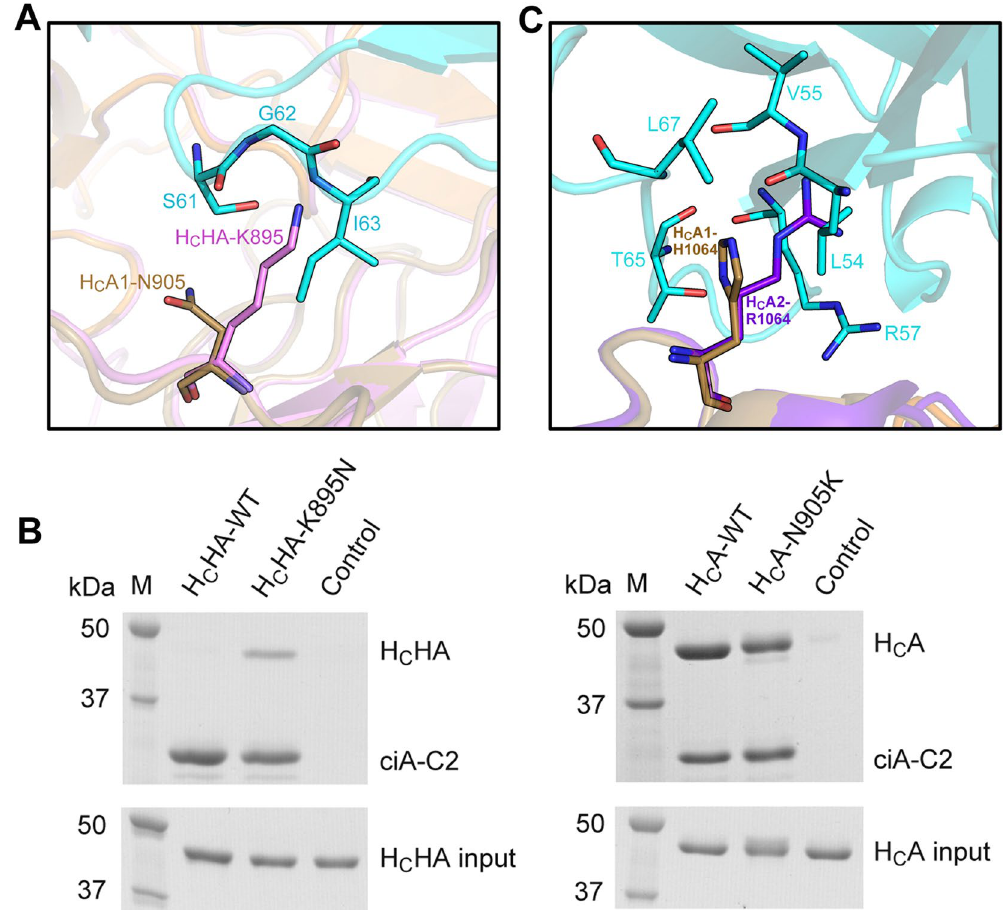
Figure 6. Subtle amino acid differences between BoNT/A1 and BoNT/HA or BoNT/A2 cause different responses to ciA-C2. ( A ) A close-up view showing potential clashes between H C HA-K895 and the CDR2 region of ciA-C2. The structure of H C HA (PDB: 5V38, colored purple) is superimposed onto the H C A1-ciA-C2 complex (H C A1: sand; ciA-C2: cyan). ( B ) Pull-down assays using ciA-C2 as a bait and H C A1 and H C HA variants as preys. Ni-NTA resins incubated with H C HA-WT (left panel) and H C A1-WT (right panel) in the absence of ciA-C2 were used as negative controls. ( C ) A close-up view at the H C A1-H1064-binding pocket on ciA-C2, where H C A2-R1064 cannot be accommodated. Structural superposition was made using the structures of H C A2 (PDB: 5MOY, colored in deep purple) and the H C A1-ciA-C2 complex (H C A1: sand; ciA-C2: